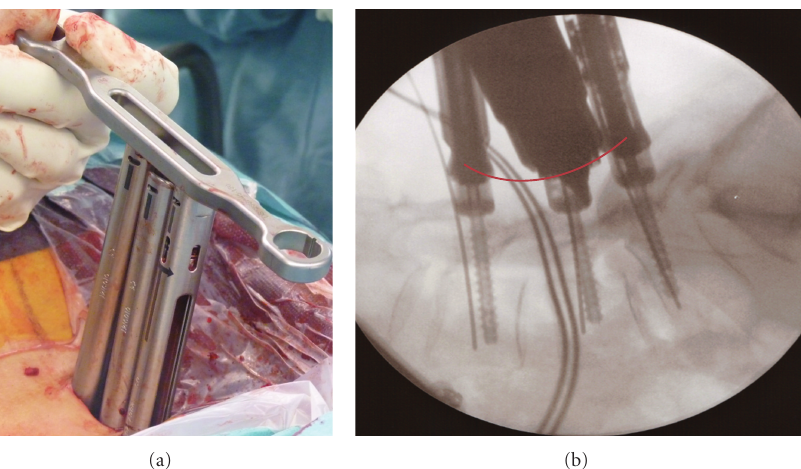
Figure 4: The optimal alignment of the heads of the screws is important. He can be controlled at the top of the screw extenders (a) or on a lateral fluoroscopic view (b). When all the fenestrated screws are optimally placed, we suggest testing the unconstraint placement of the rod to avoid positioning issues during the definitive rod placement after cement injection.